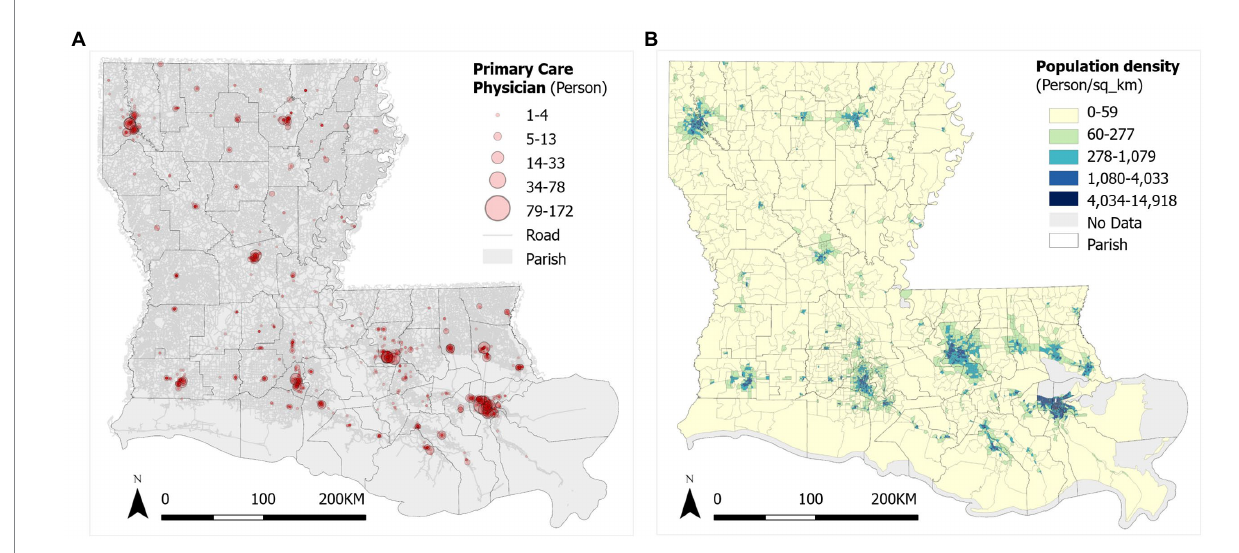
FIGURE 1 Distributions of (A) primary care physicians (PCPs) and (B) population density in